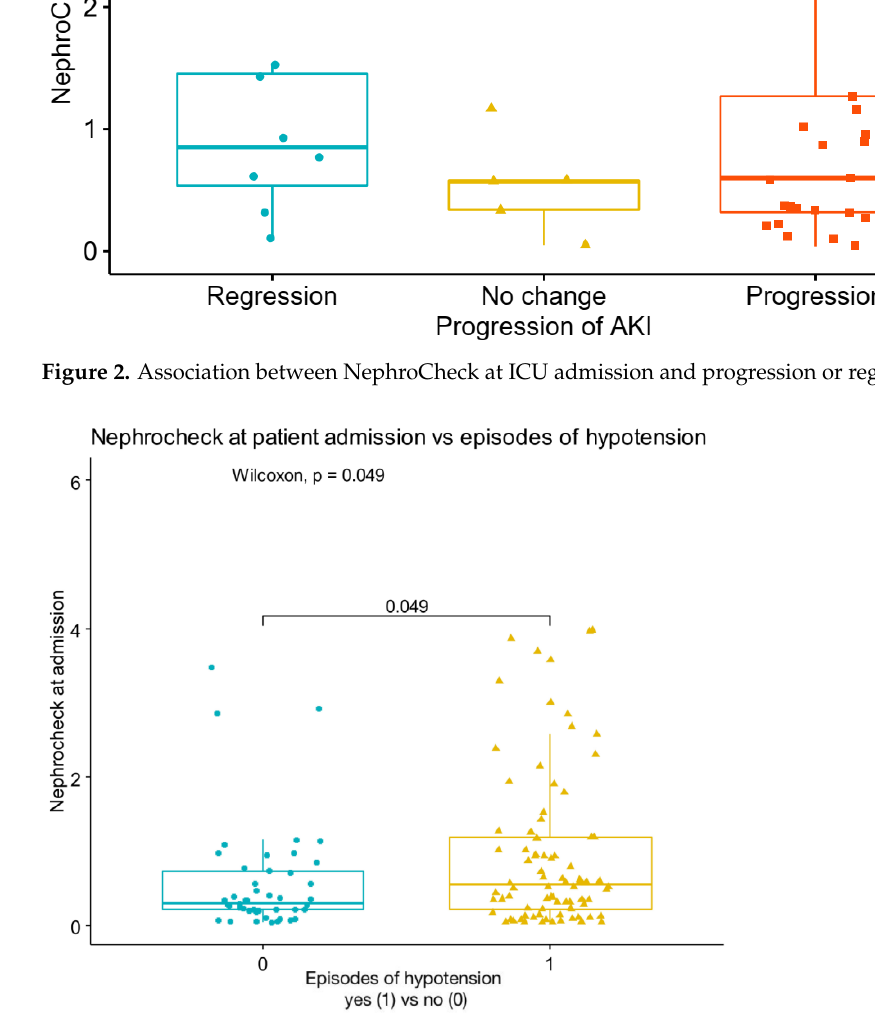
Figure 3. Correlation between NephroCheck at ICU admission and episodes of hypotension.